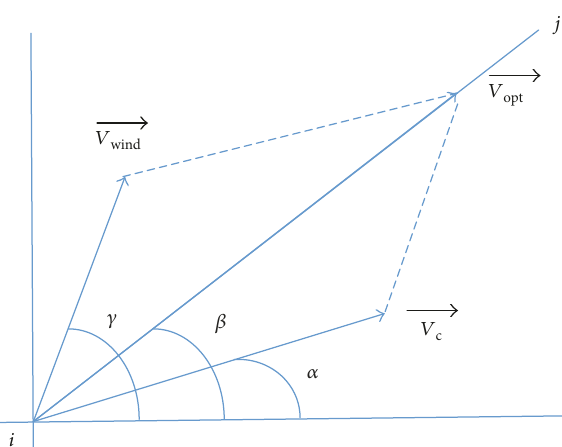
Figure 6: Speed adjustment under e ff ect of wind velocity